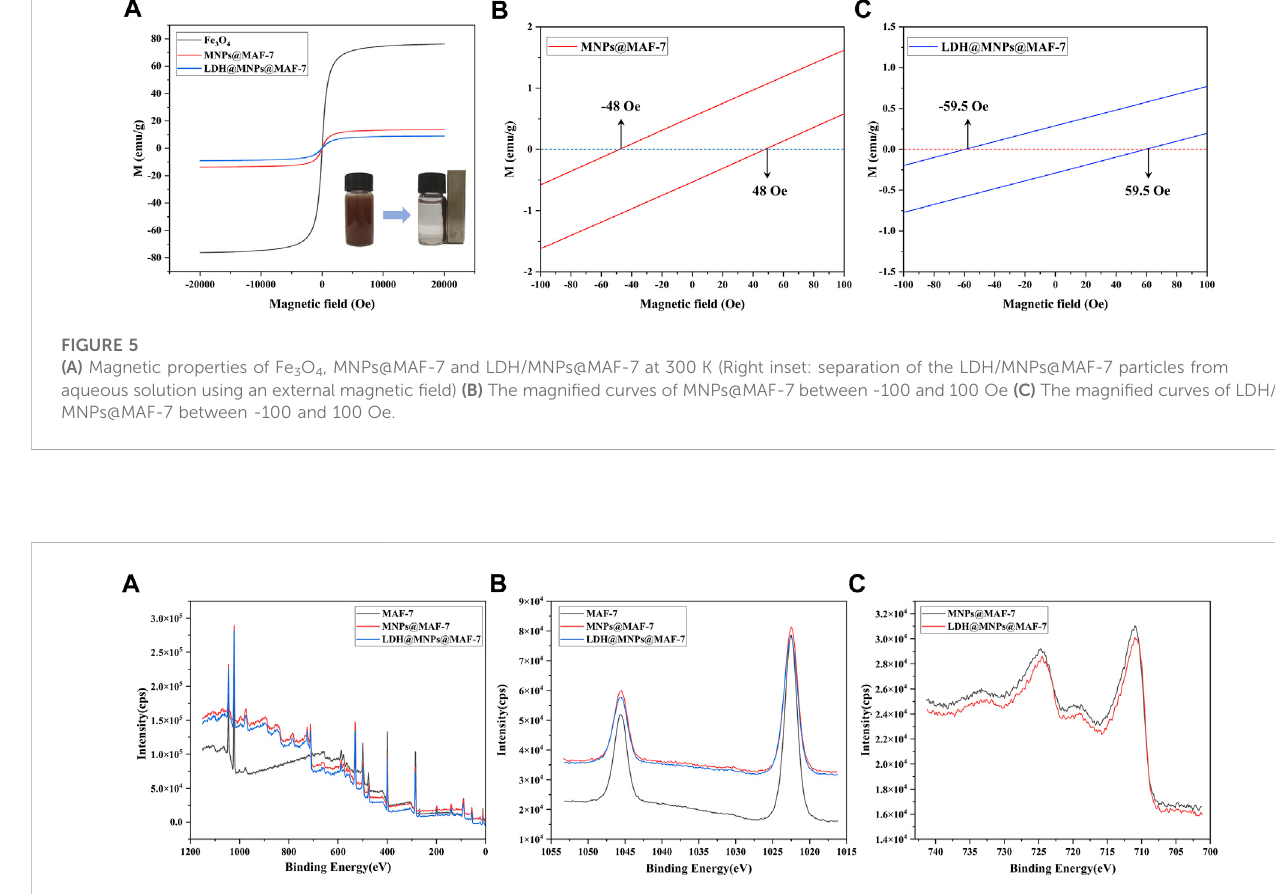
FIGURE 6 (A) XPS spectra of MAF-7, MNPs@MAF-7 and LDH/MNPs@MAF-7 (B) XPS spectra of Zn 2p in MAF-7, MNPs@MAF-7 and LDH/MNPs@MAF-7; and (C) XPS spectra of Fe 2p in MNPs@MAF-7 and